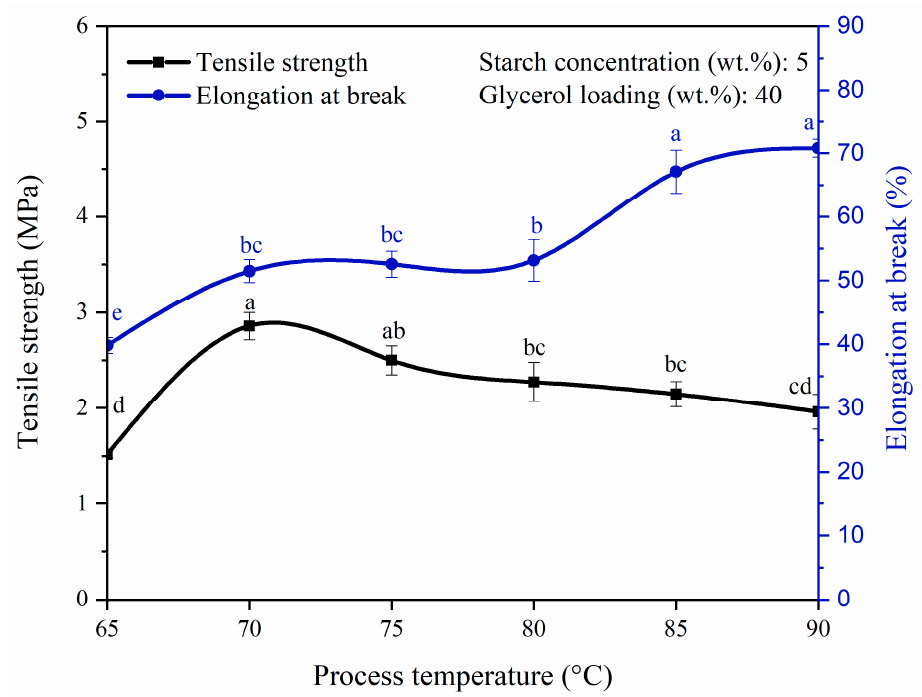
Figure 4. Tensile strength and elongation at break of pure starch-based bioplastic films at different process temperatures. Different letters indicate the values are significantly different ( p < 0.05).